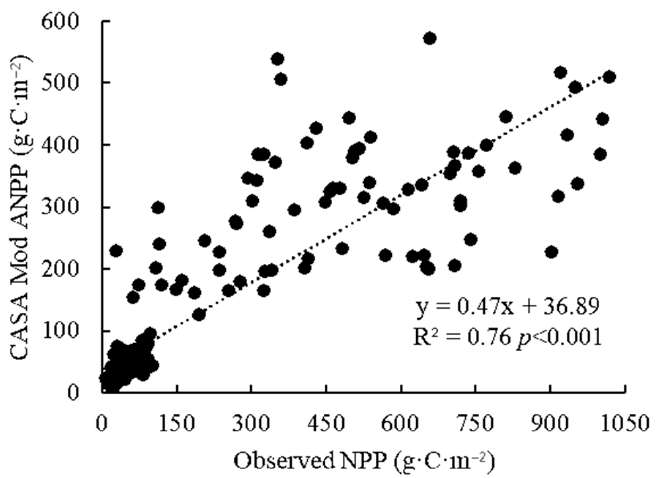
Figure 2. Comparison diagram between the observed NPP and the ANPP simulated by the modified CASA model.